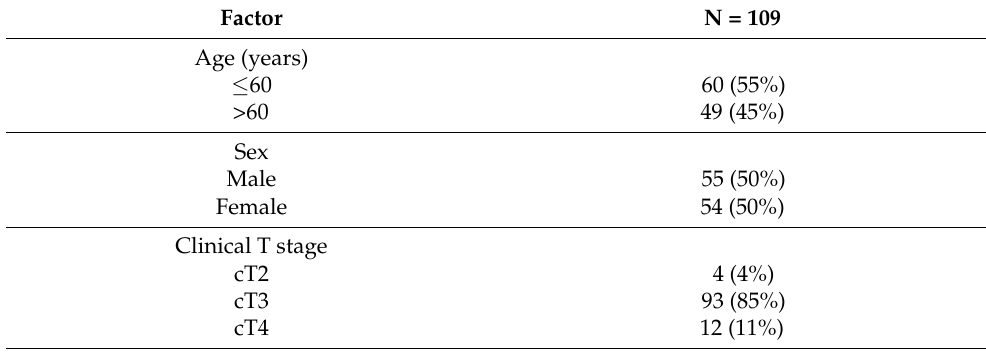
Table 1. Patient and tumor